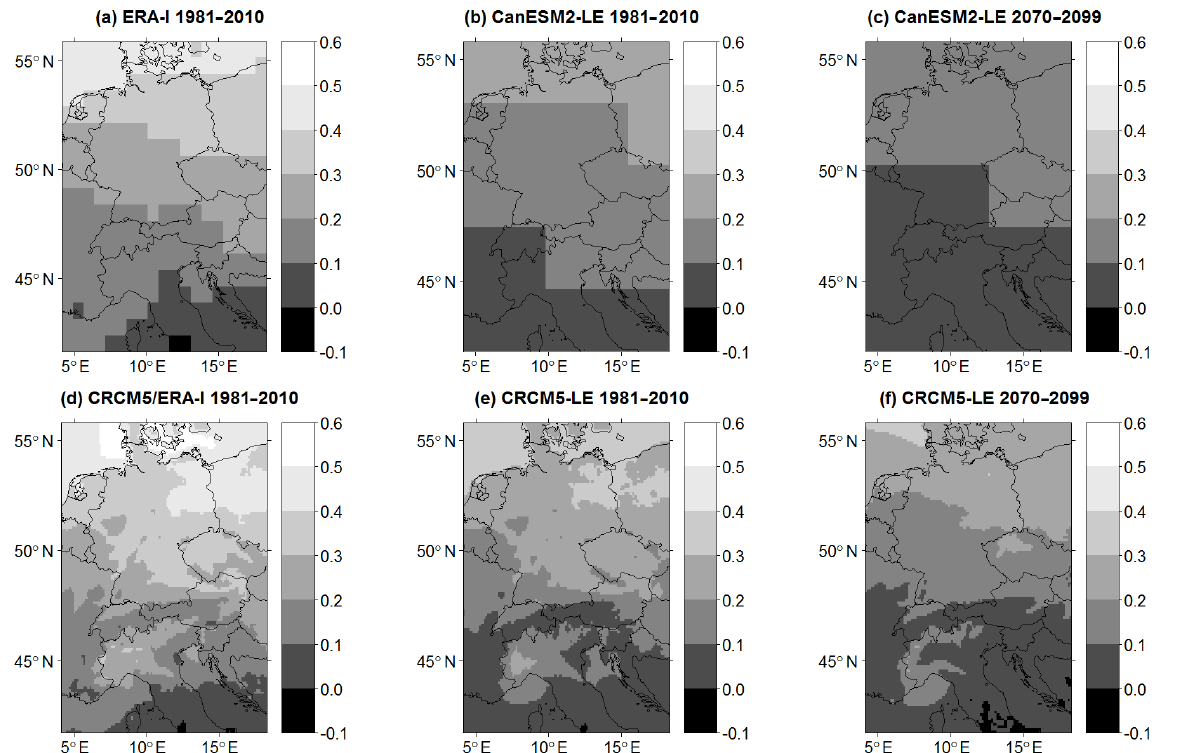
Figure A2. Ratio of nSAT α 1 and winter mean daily standard deviation of nSAT for driving data (a–c) and RCM data (d–f) during his- torical (a, b, d, e) and future (c, f) conditions. The panels show the proportion of nSAT α 1 in winter mean daily standard deviation of